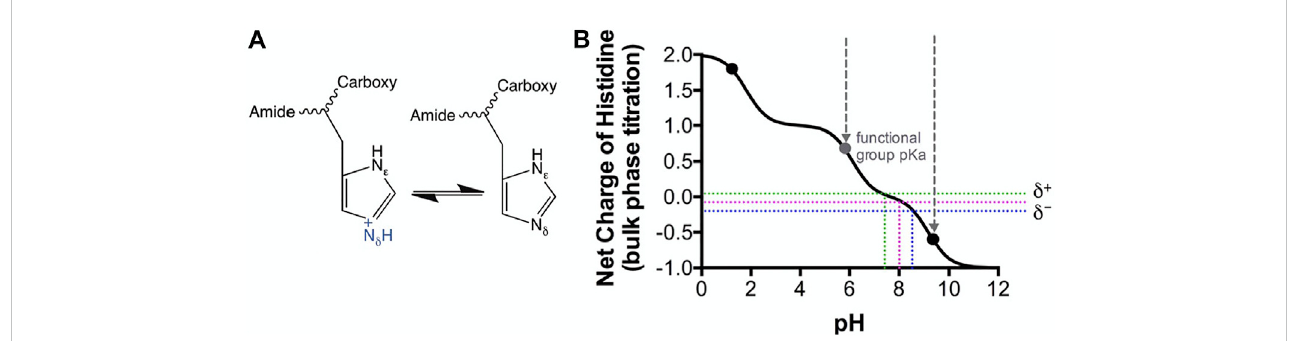
FIGURE 5 Modeled Histidine pKa shifts vs. pH. Histidine as a soluble amino acid was modeled vs pH using CurTiPot (Krah and Takada, 2016). (A) Lewis model of histidine chemistry showing gain and loss of a proton. (B) Model of histidine pK a shift. Black dots indicate the pK a values for histidine in solution. Perforated coloured lines indicate the pH values over which the histidine imidazole ring pK a has a distribution between 1 – 0 net charge. pH values of 7.0 and 8.5 are indicated by the green and blue lines respectively. Perforated grey lines indicate the pH window of the functional group pK a